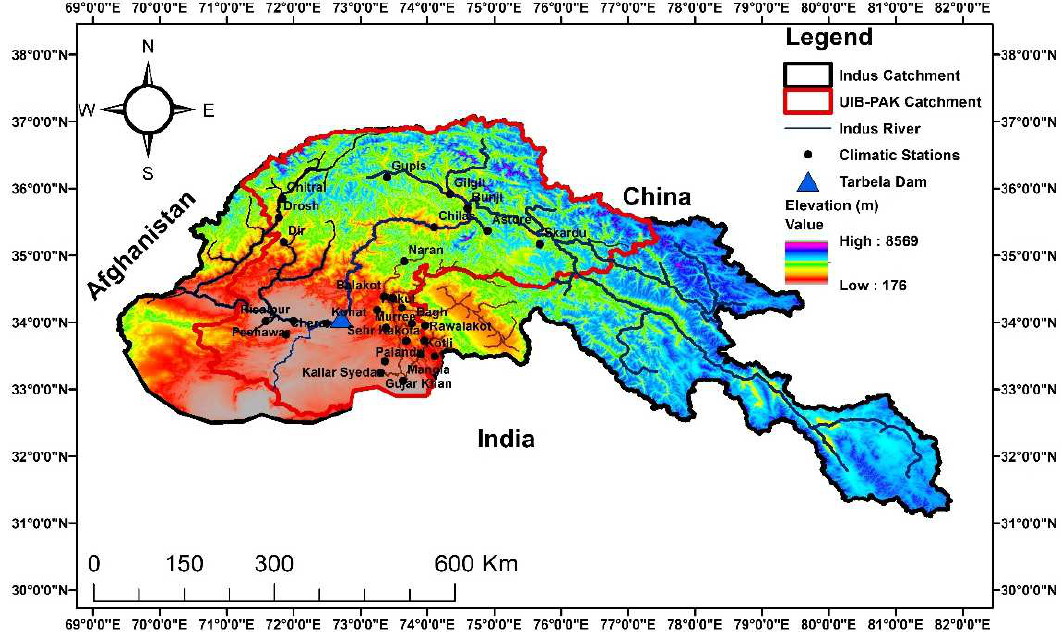
Figure 1. Network of installed climatic stations in the UIB.